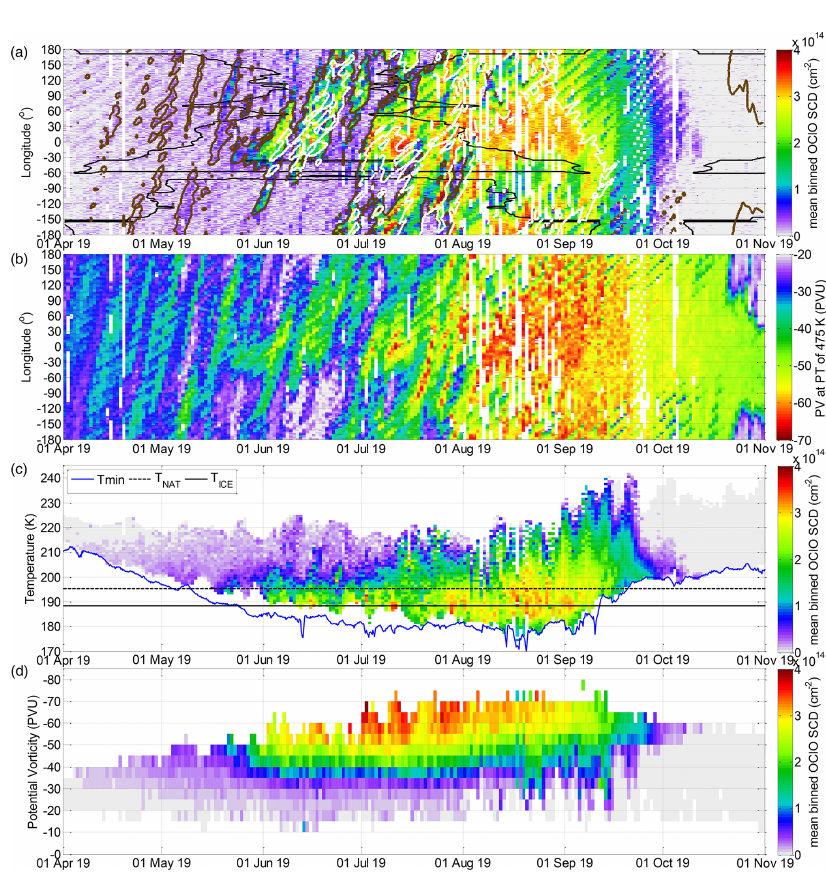
Figure 14. Same as Fig. 11 but for the Antarctic winter 2019.